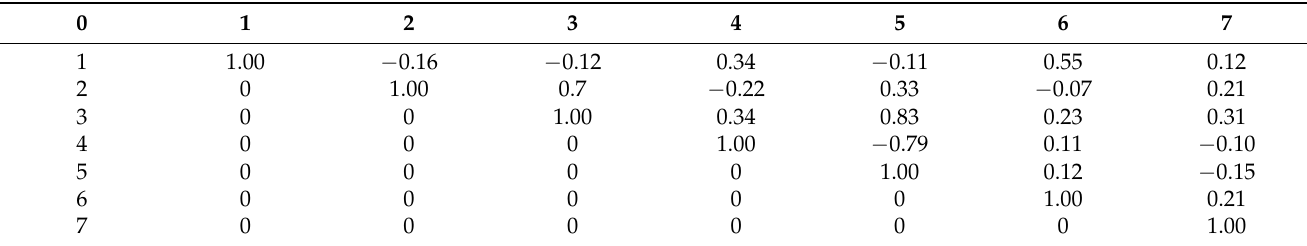
( 2 ) ( i ) ; ν ,i = 1,7 (preceding crop—maize). 1 ν